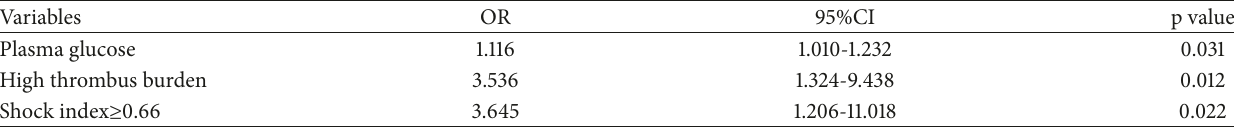
Table 3: Multivariate analysis of risk factors for patients with normal flow and slow/no